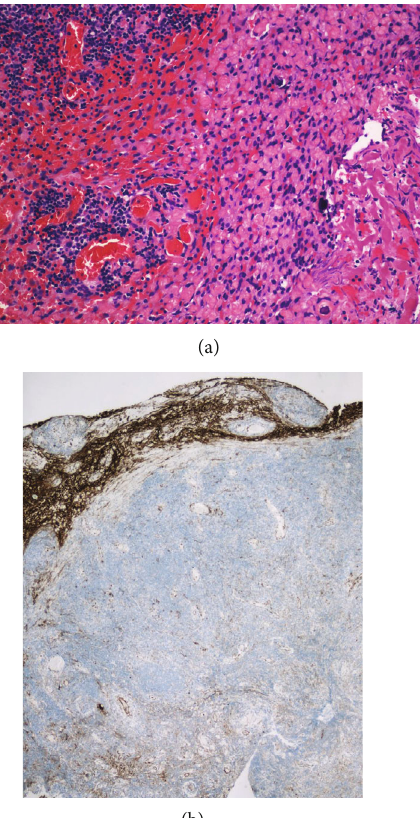
Figure 2: (a) Routine H&E stain demonstrates peripheral scattered meningothelial cells. (b) These meningothelial cells are highlighted by somatostatin receptor 2a